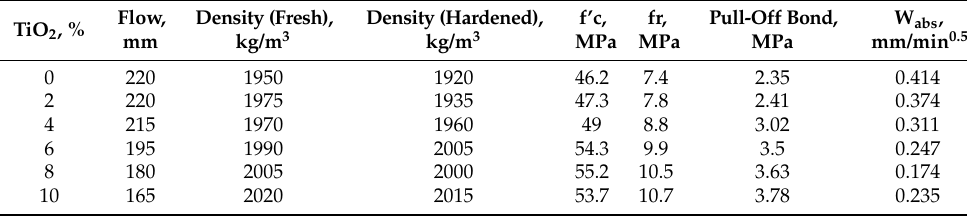
Table 1. Flow, density, and hardened properties of cement slurries.